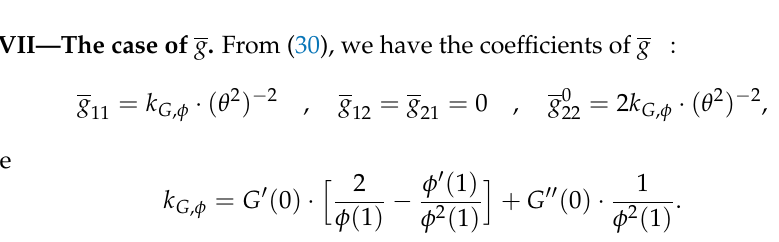
Figure 7. The variation of ˆ S { c } w.r.t. c and θ 2 : = t